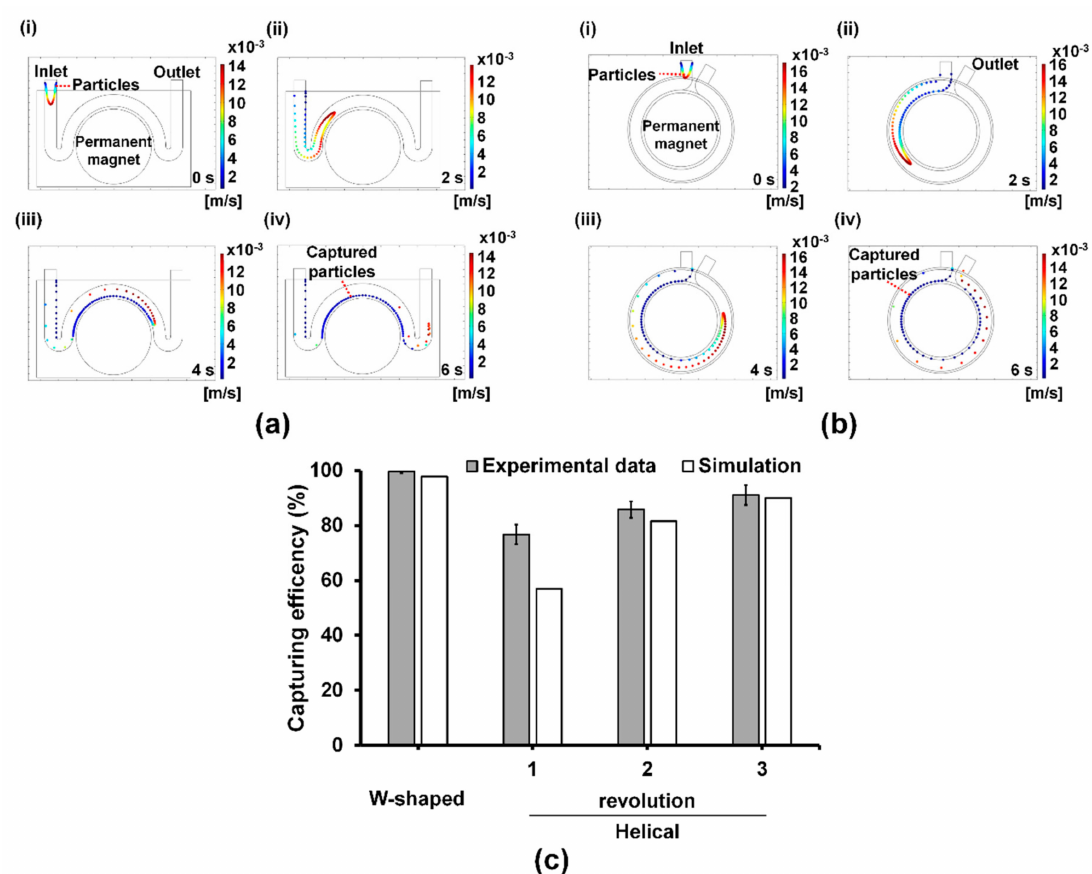
Figure 3. Comparison between simulation and experimental results. CFD simulation by COMSOL Multiphysics ® software (ver. 5.1) in the W-shaped ( a ) and helical ( b ) microchannels (Figure S1). Each dot and its color represent a single bacterium-Ab-MNP complex and its velocity, respectively. In the simulation bacterium-Ab-MNP complexes (one hundred complexes) were injected into the inlet of both microchannels at 0 s at a flow rate of 2 mL / min, while a magnetic field was applied to the complexes from the center of the microchannel. Average magnetic field applied to the W-shaped and helical microchannels was 528 mT and 115 mT, respectively. ( c ) Simulation and experiment results of bacterial capturing e ffi ciency for the W-shaped and helical microchannels. Bacterial capturing e ffi ciency was estimated by counting the number of the complexes in the channel and